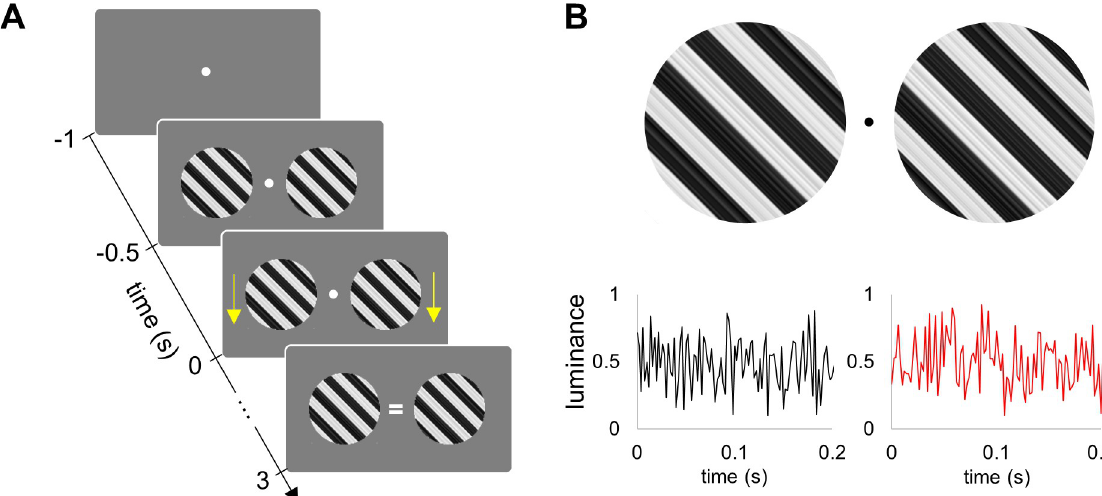
Fig 12. Experimental paradigm. (A) Grating stimuli were presented for 0.5 s and then the left and right gratings started contracting for 3 s either coherently (same direction) or incoherently (different directions). Yellows arrows on this figure (were not visible in the experiment) indicate coherent motion downwards. The cue (‘ = ‘) indicates coherent motion. (B) Luminance of the left and right grating stimuli was modulated by two independent broadband signals. The modulation (visual flicker) started at the time -0.5 s, together with the onset of grating